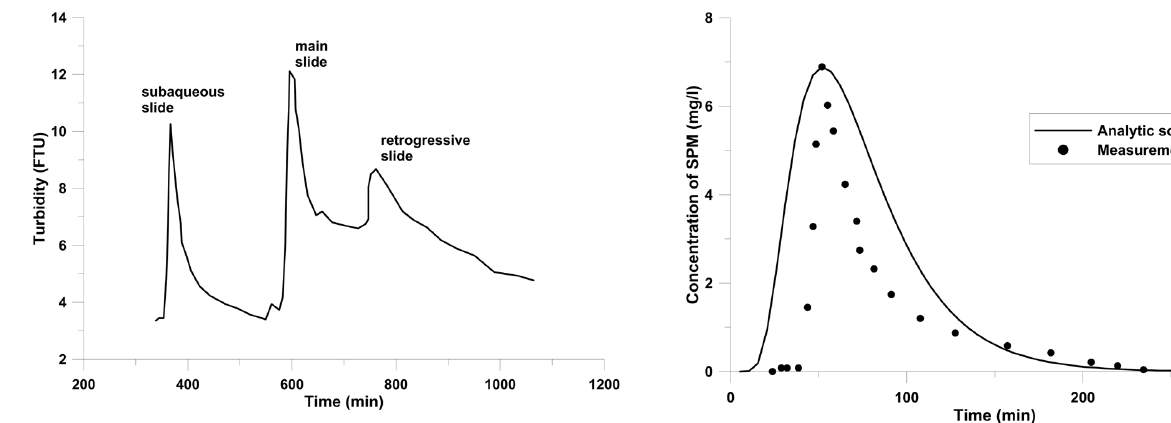
C:\Documents and Settings\brigitte.wilhelm\Desktop\Subversion\Journals\hess\hess-2011-329\author\hess-2011-329-manuscript- version4.doc